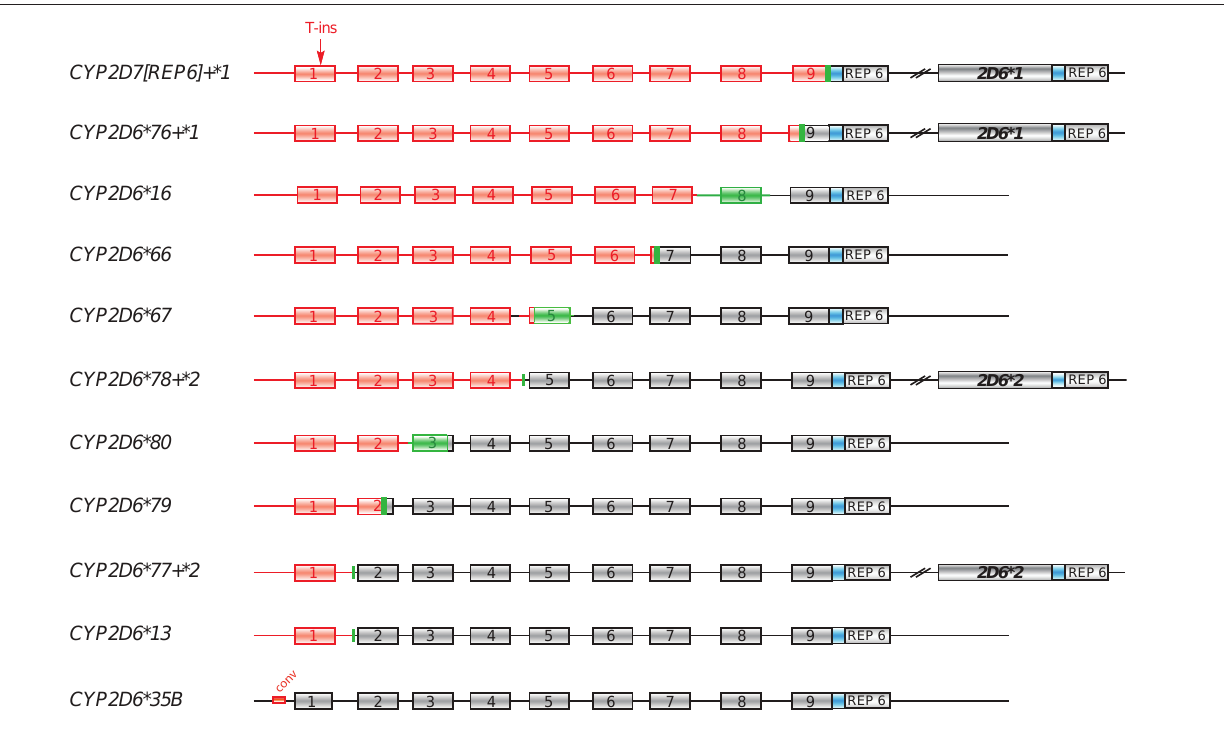
aligned with CYP2D7 (M33387) and CYP2D6 (M33388) reference sequences to approximate the switch region. For completion, the graph also shows previously reported CYP2D6 * 76 + *1, *77 + *2, and * 78 + *2 tandem hybrids (Gaedigk et al., 2010) as well as the CYP2D6 * 13 and * 16 alleles (no reference sequences